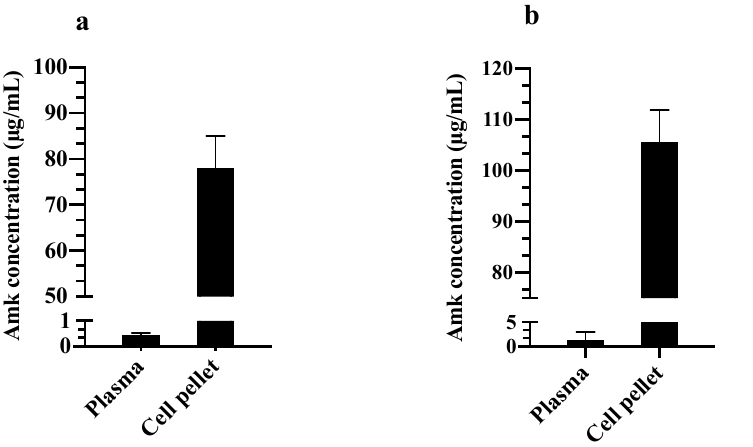
Figure 4. Drug levels in plasma and blood cell pellets measured at 24 h after i.n. administration of the Amk solution ( a ) and the Amk-DCA suspension ( b ) (mean ± standard deviation, n = 3).